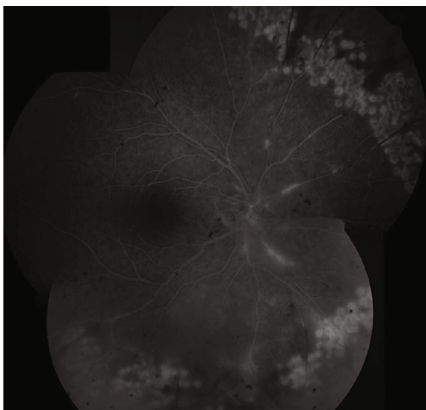
Figure 3: Fundus fl uorescein angiography montage image (Canon 60UVi, Tokyo, Japan) showing ischemic areas in the laser periphery, leakage in the head of the optic disk, and